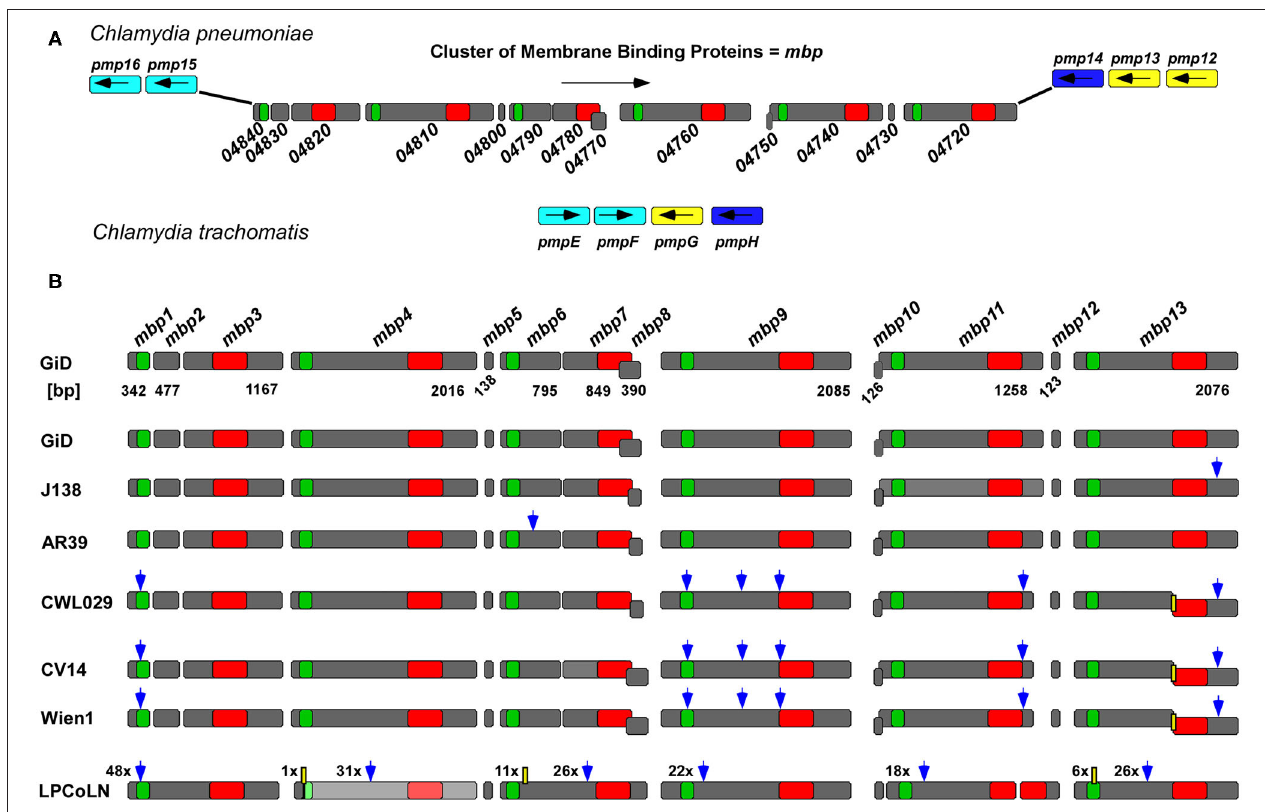
FIGURE 1 | The GiD_A_mbp1-mbp13 gene cluster is specific for Cpn . (A) Genomic context of the Cpn GiD mbp1-mbp13 gene cluster located between pmp15 ( C. tr. homolog pmpE/F, light blue) and pmp14 ( C. tr. homolog pmpH, dark blue) in comparison to the configuration of the corresponding homolog genes in the genomic locus in C. trachomatis where pmpG (yellow) is inserted in between pmpE/F and pmpH . Each dark gray box symbolizes one gene, and the arrows indicate their orientations in the genome. The distribution of the two predicted DUF domains, DUF575 (green box) and DUF562 (red box) is indicated. (B) Comparison of the GiD mbp1-mbp13 gene cluster with its counterparts from six different Cpn isolates from humans and the chlamydial strain LPCoLN recovered from the koala ( Phascolarctos cinereus ), which is regarded as a hypothetical ancestor of human Cpn strains. The scheme shows all detected sequence variations between the genes in different isolates relative to GiD. Blue arrow: bp exchange; yellow box: deletions (the digits give the number of exchanges or deletions). While GiD J138 and AR39 contain 13 genes in CWL029, CV14, and Wien1 mbp13 is split into two genes due to a 1 bp deletion resulting in a premature stop and a new downstream start codon. In the LPCoLN isolate the mbp4 homolog, indicated in light gray, is non-functional, carrying an N-terminal stop codon.